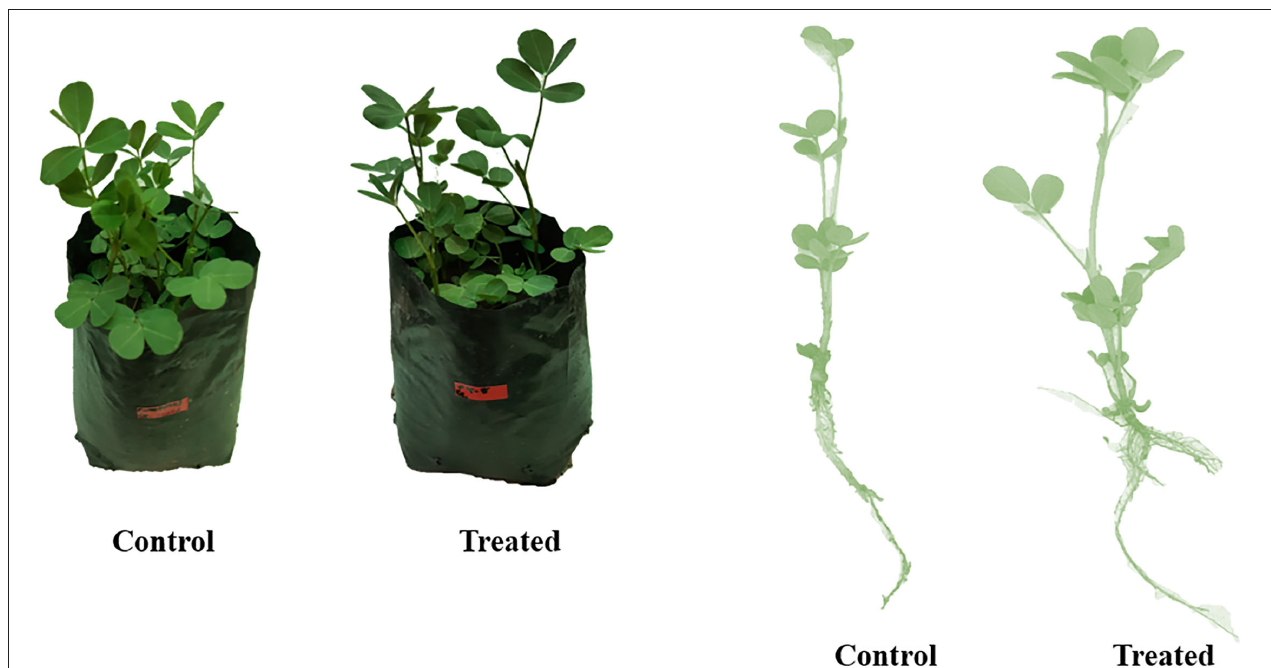
FIGURE 6 | Arachis hypogea plant after 30